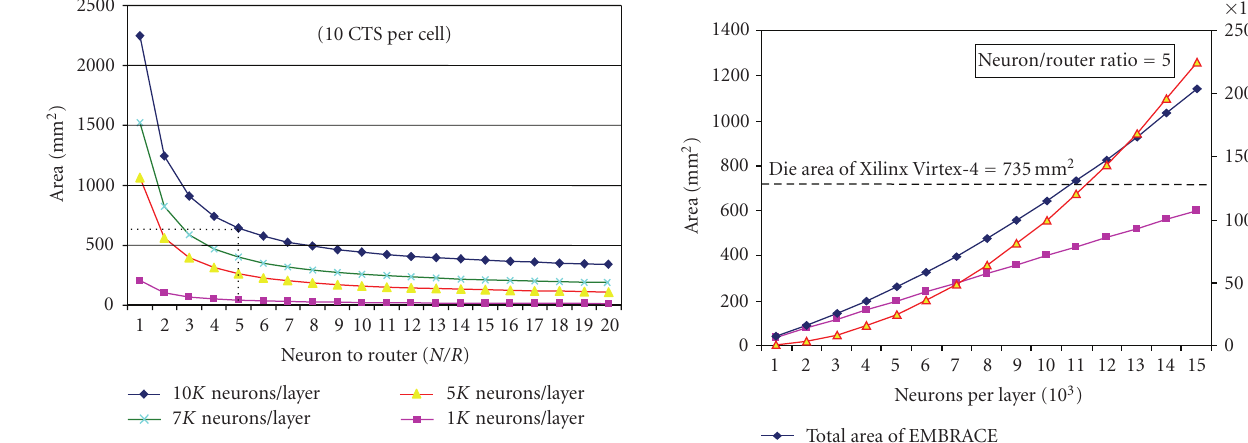
Figure 11: Optimisation: increasing number of neurons per tile.